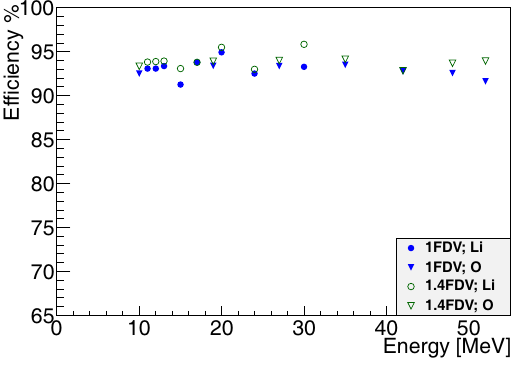
Figure 1: Efficiency for full energy detection as a function of the beam energy, for two different bias voltages applied to the detector. In the left panel is shown the efficiency obtained imposing the condition E front ≈ E back , the continuous line corre- sponds to the efficiency for the full energy detection calculated using the geometrical interstrip width; in the right panel is shown the efficiency obtained recovering the back interstrip events. See the text for more